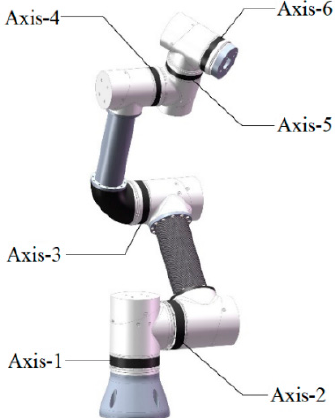
Figure 1. 3D model of the collaborative robot.